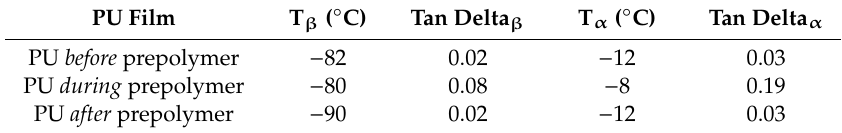
Figure 14. ( a ) Variation of the storage modulus (E’) as a function of the temperature, and ( b ) variation of tan delta as a function of the temperature for PU films. DMA experiments. Table 6. Values of the temperature and tan delta of the relaxations of the PU films. DMA experiments.